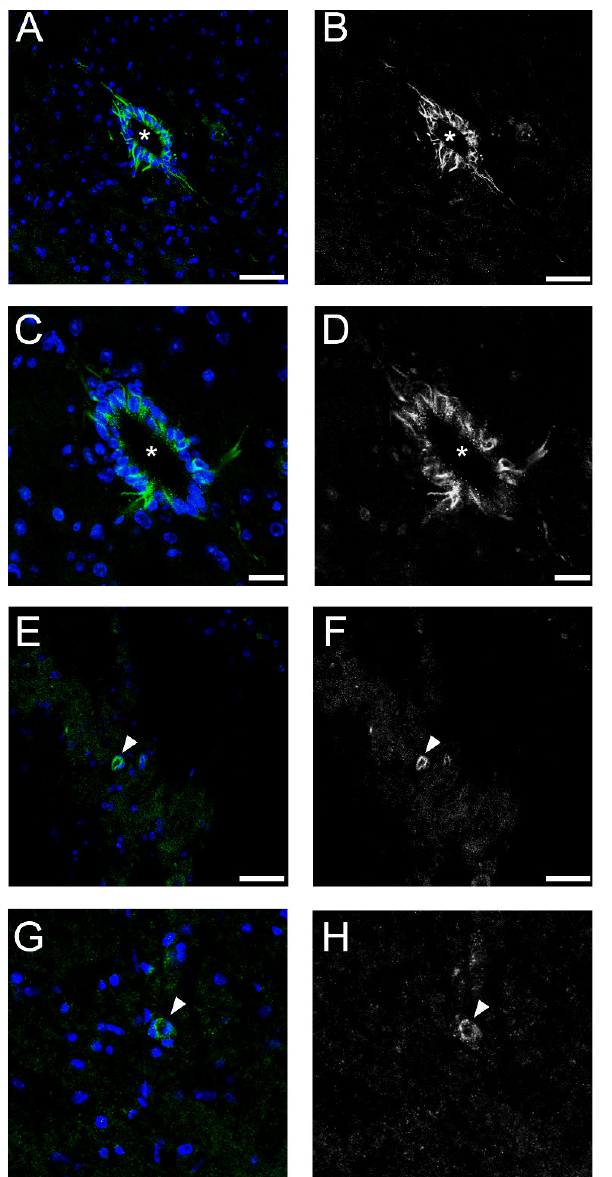
Fig. 3. Immunohistochemical detection of GalR1 in the spinal cord. The intensity of GalR1 immunoreactivity was comparable between the samples from the EAE mice and the control mice.